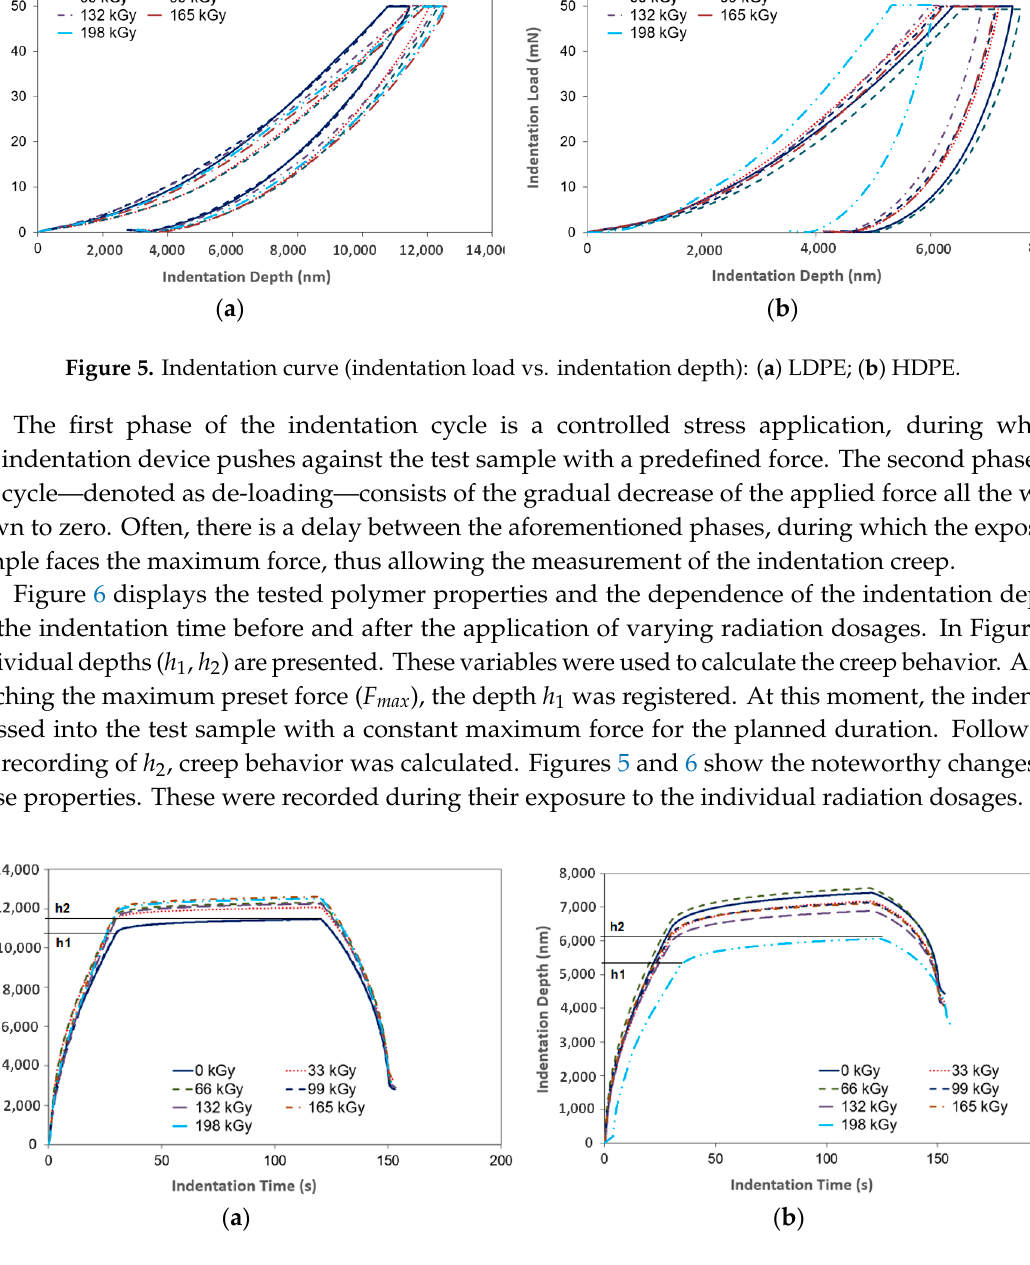
Figure 6. Indentation creep (indentation depth vs. indentation time): ( a ) LDPE; ( b ) HDPE